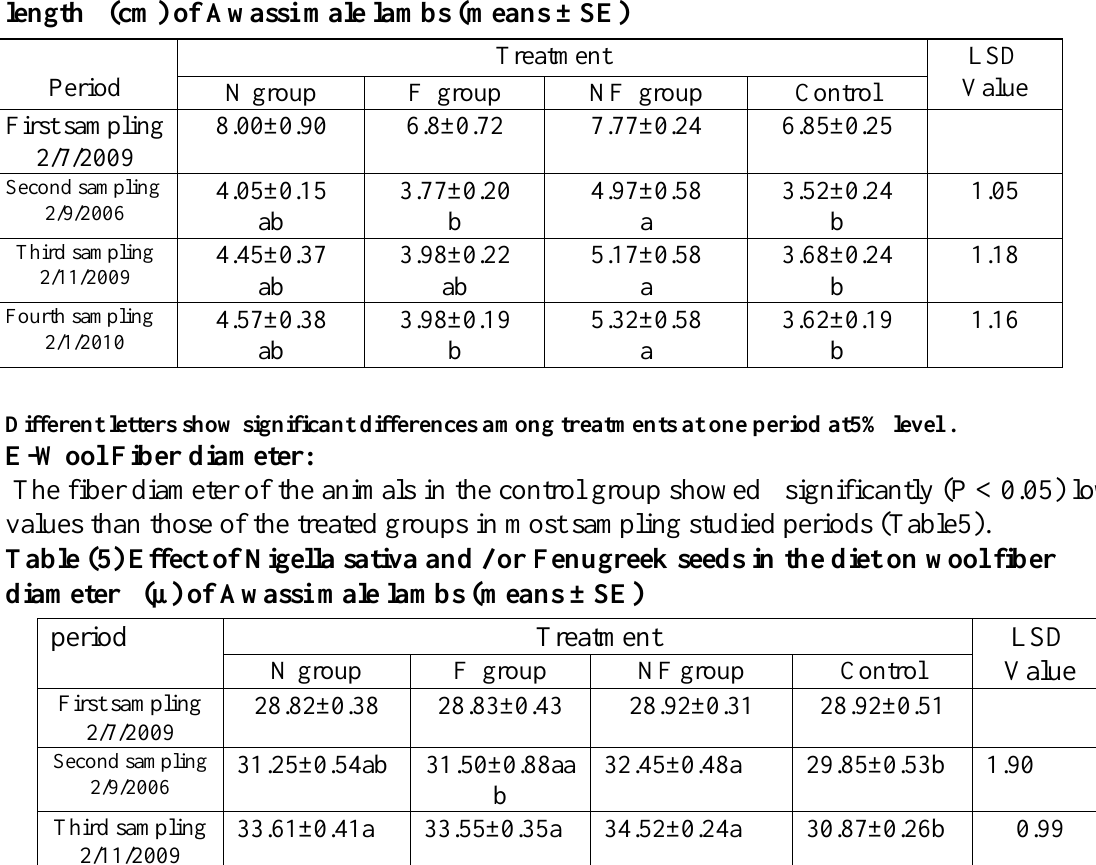
Different letters show significant differences among treatments at one period at5% level